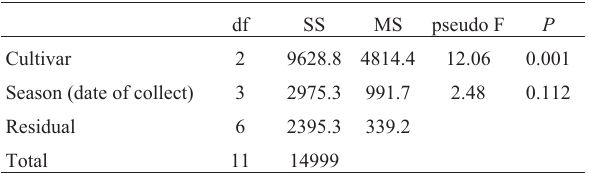
Table 5 - PERMANOVA analyses of the microbial communities associ- ated with coffee genotypes. df